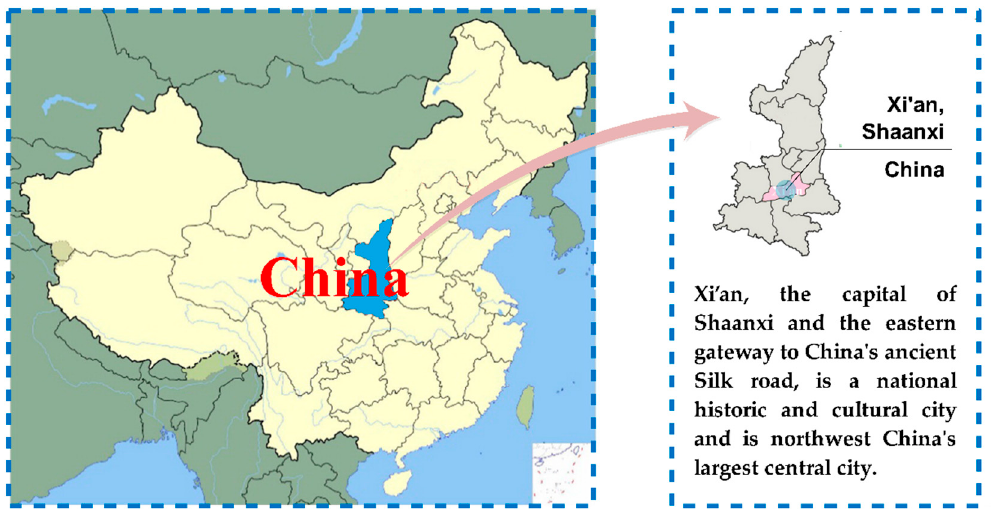
Figure 1. Specific location of the study area.